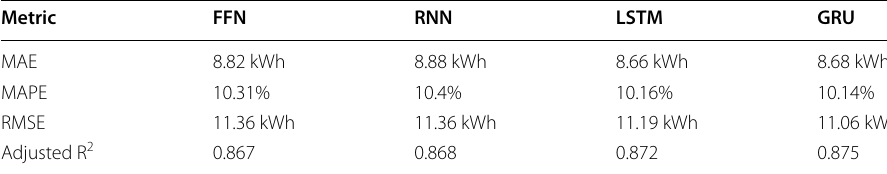
Table 3 Baseline neural networks